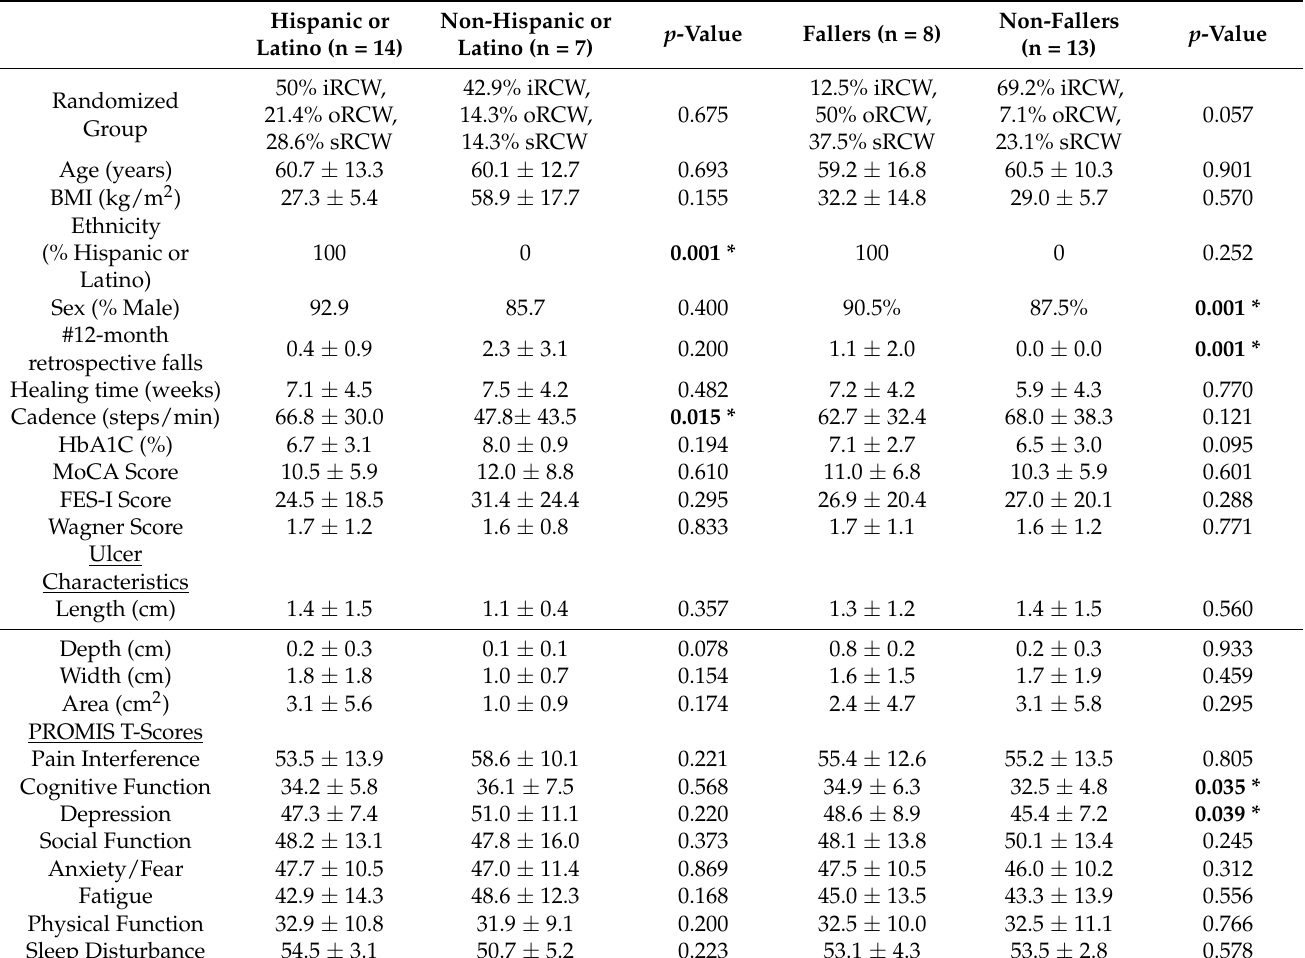
Table 1: Participant characteristics by ethnicity (Hispanic or Latino, Non-Hispanic or Latino) and fall status (fallers, non-fallers). Kruskal–Wallis (randomized study group), Chi-squared (ethnicity, sex) and Mann–Whitney U tests (all other items) were used to determine statistical significance. 2-sided p -values of p ≤ 0.05 were considered significant. Bolded p -values with asterisks (*) denote